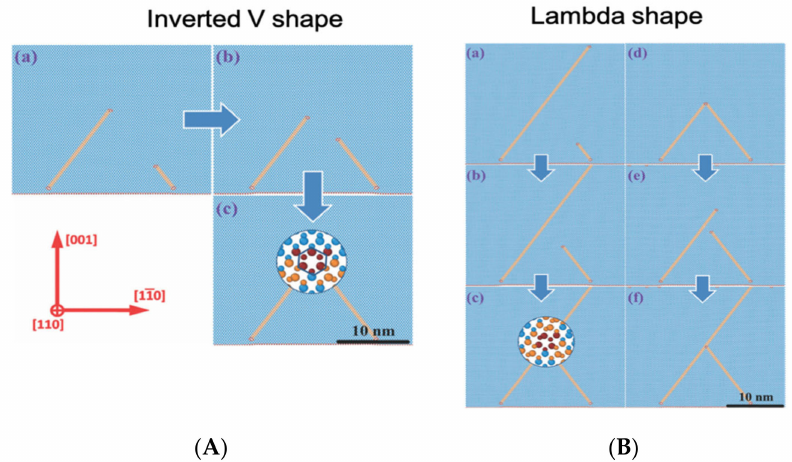
Figure 12. ( A ) Molecular dynamics simulation snapshots of the inverted V-shape configuration. (a–c) The simulation time: (a)—0, (b)—120 ps, and (c)—180 ps. Blue atoms correspond to the Si